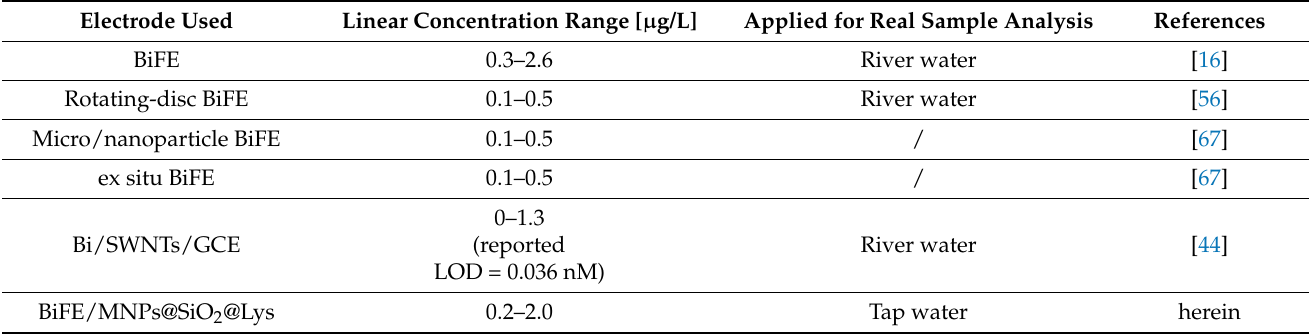
Table 2. A summary of the SWAdSV technique using BiFE/MNPs@SiO 2 @Lys with previously reported electroanalytical techniques using DTPA as a complexing agent (Bi/SWNTs/GCE stands for the Bi-film wrapped single-walled carbon nanotubes-modified GCE).